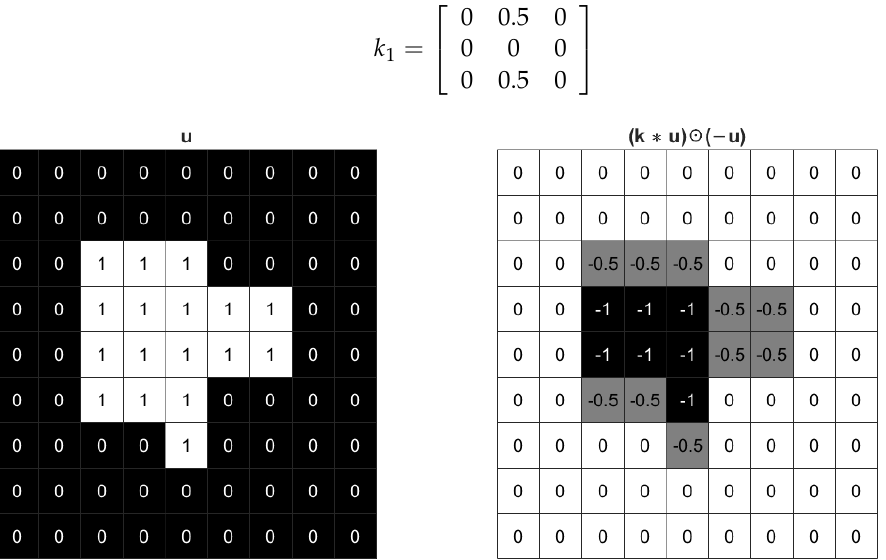
Figure 3. The effect of a 3 × 3 vertical kernel k 1 for an